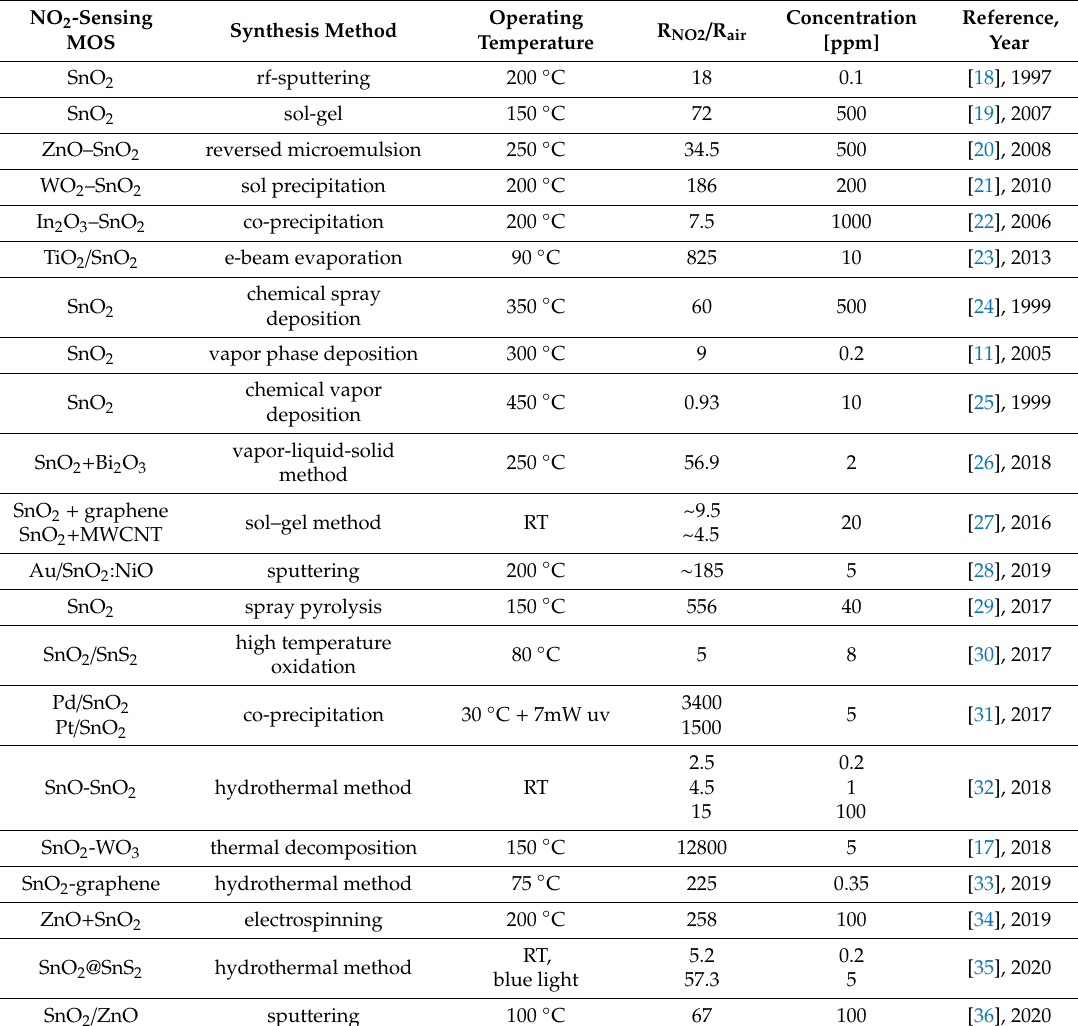
Table 1. Survey of NO 2 -sensing materials based on SnO 2 prepared by various physical and chemical